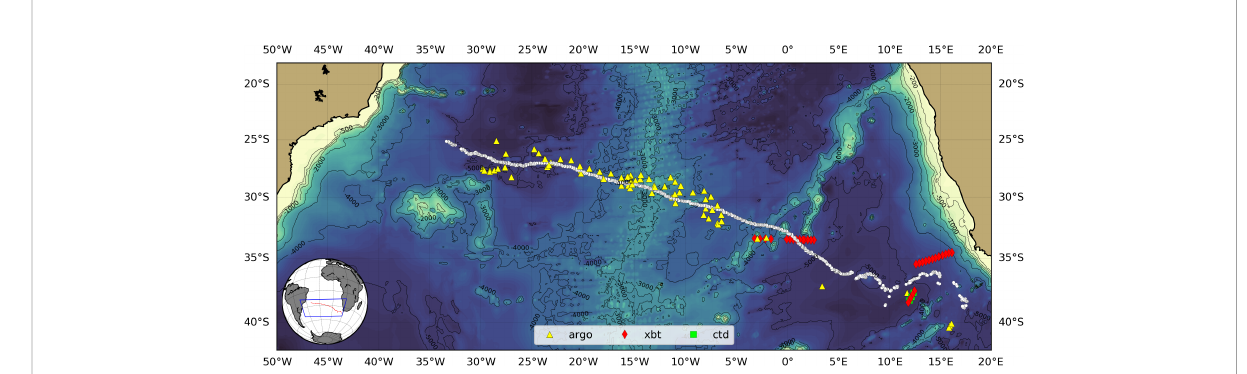
FIGURE 6 The path of the Ring Ana between 15-Aug-2004 and 09-May-2007 (white dots) and the locations of Argo (yellow), XBT (red diamonds), and CTD (green squares) pro fi les within the ring radius. The bottom topography is shown in the